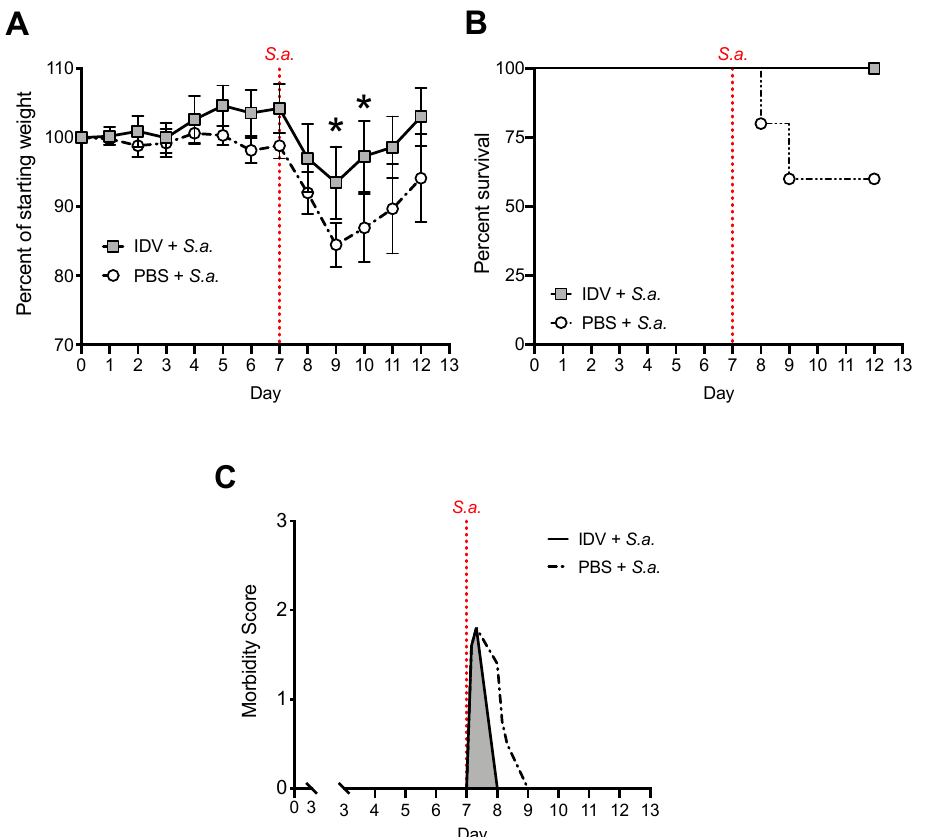
Figure 4. C57BL / 6 (WT) mice were inoculated with OK11 (IDV; grey boxes) or PBS (white circles) on day 0 and challenged with S. aureus ( S.a.) on day 7 (indicated by dotted red line). ( A ) Percent initial body weight (compared to day 0), ( B ) survival, and ( C ) signs of morbidity were monitored and measured daily. Experiments had a minimum of 5 animals per group and were repeated two times. Data are represented as mean ± SD. *, p < 0.05 (comparing groups on days 9 and 10 post-OK11) using Student’s t test.